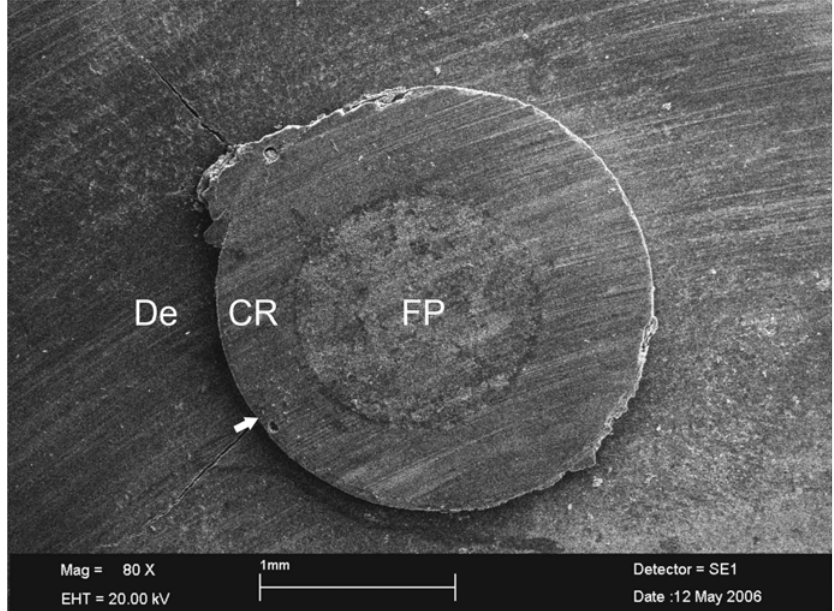
FIGURE 2- Relined fiber post specimen after the push-out test. Note that the failure also occurred in the interface between the resin cement and the dentin. Dentin (De), Fiber-post (FP), Composite resin (CR) and Cement resin